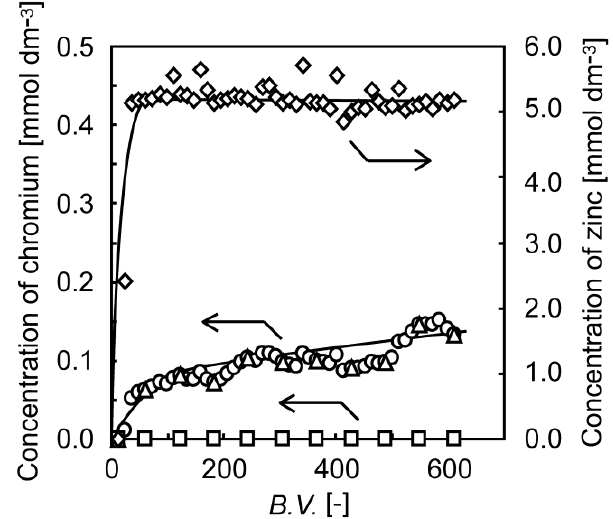
Figure 12. Breakthrough profiles of various chromium and zinc species from the column packed with CPW gel at pH = 1.0 [23] (with permission for reuse from Elsevier B.V.). ○: Total Cr ∆: Cr(III) □: Cr(VI) ◊: